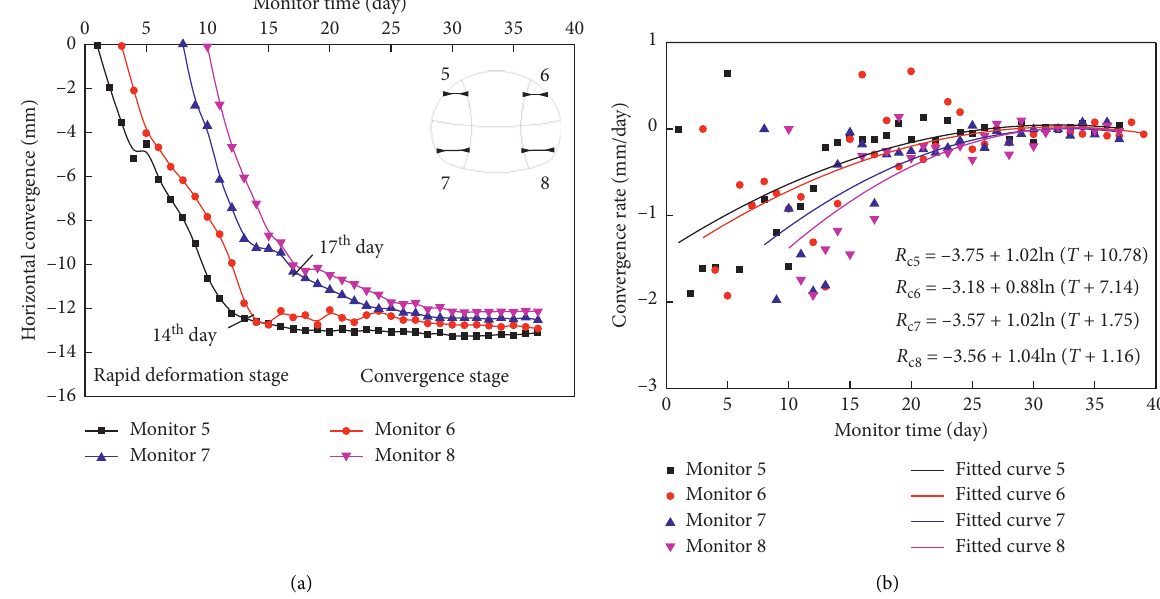
Figure 19: Horizontal deformation and convergence characteristics. (a) Time-history curve of horizontal deformation. (b) Time-history curve of deformation rate of horizontal